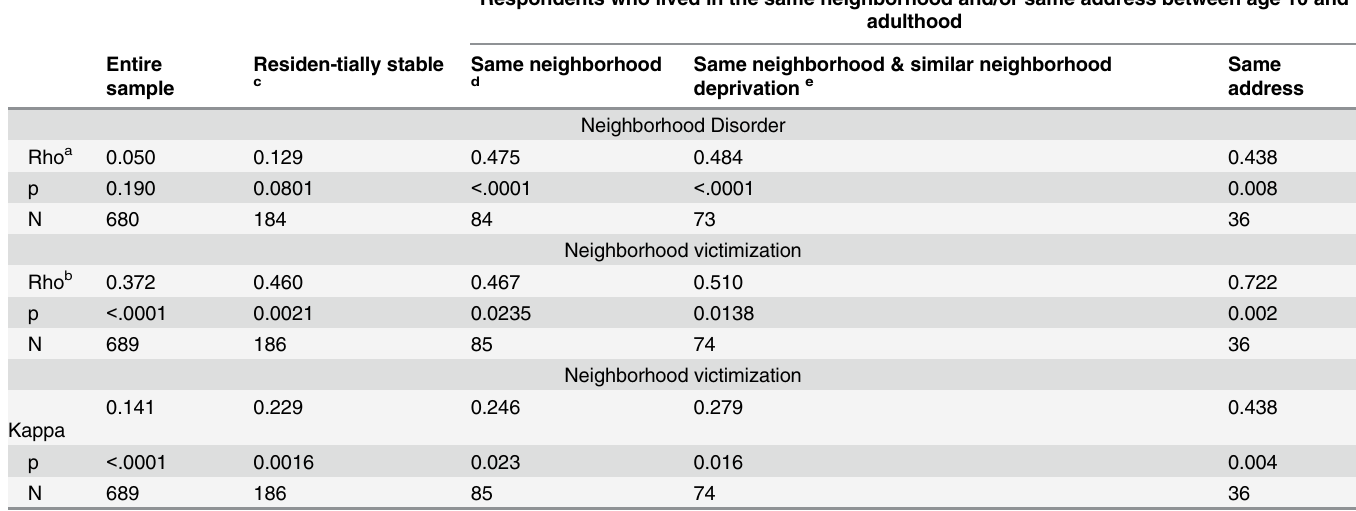
Table 4. Comparing childhood and adulthood neighborhood measures, entire sample and among residentially-stable subgroups; LIFE Study. Respondents who lived in the same neighborhood and/or same address between age 10 and